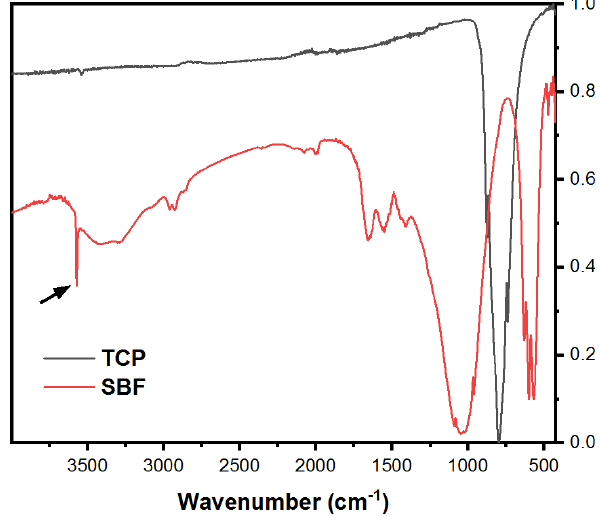
Figure 9: The FT-IR spectra of the pristine TCP sample versus the soaked TCP sample in SBF after 14